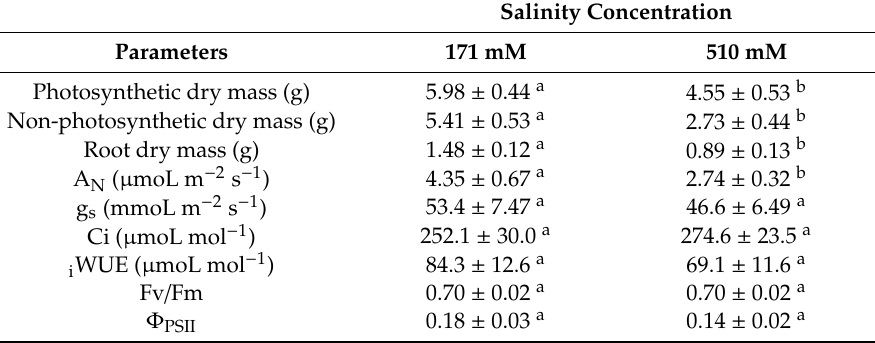
Table 1. Photosynthetic dry mass, non-photosynthetic dry mass, root dry mass (Rt), net photosynthetic rate (A N ), stomatal conductance (g s ), intercellular CO 2 concentration, (C i ), intrinsic water use e ffi ciency ( i WUE), and maximum quantum e ffi ciency of photosystem II (PSII) photochemistry (F v / F m ) and quantum e ffi ciency of PSII ( Φ PSII ) of Atriplex halimus L. in response to treatment with 171 and 510 mM NaCl for 60 d. Biomass and physiological parameter values represent mean ± SE, n = 16 and n = 12, respectively. Di ff erent letters indicate means that are significantly di ff erent between both salinities (ANOVA test, p < 0.05).